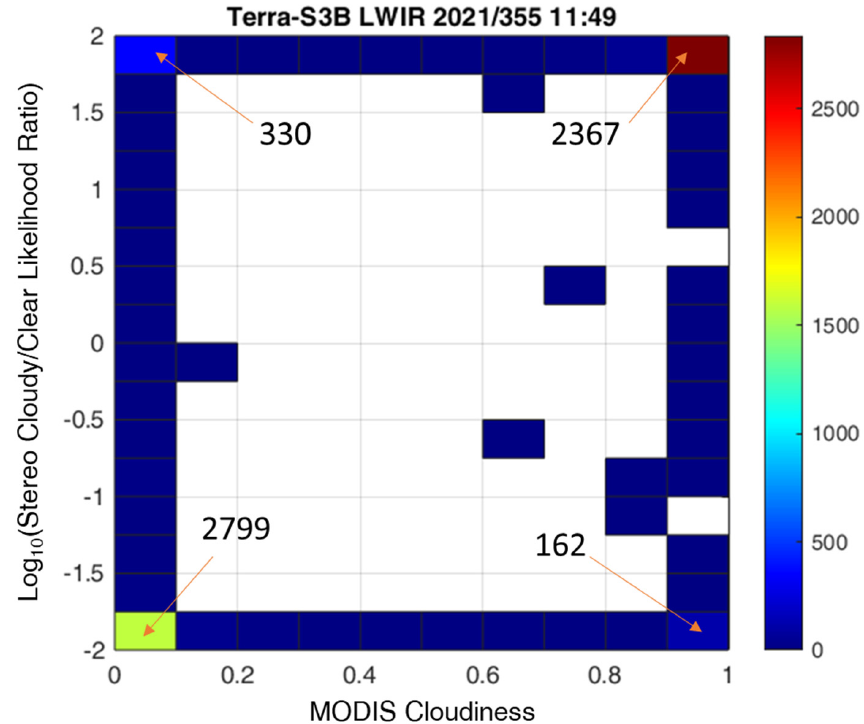
Figure 14. Comparison of MODIS and stereo-cloud classifications for a North Polar winter case (21 December 2021) for a single overpass at 11:49Z. A likelihood ratio of 100 is a certain cloud and 0.01 is certain clear sky. All likelihood ratios greater than 100 or less than 0.01 are assigned to 100 or 0.01, respectively.